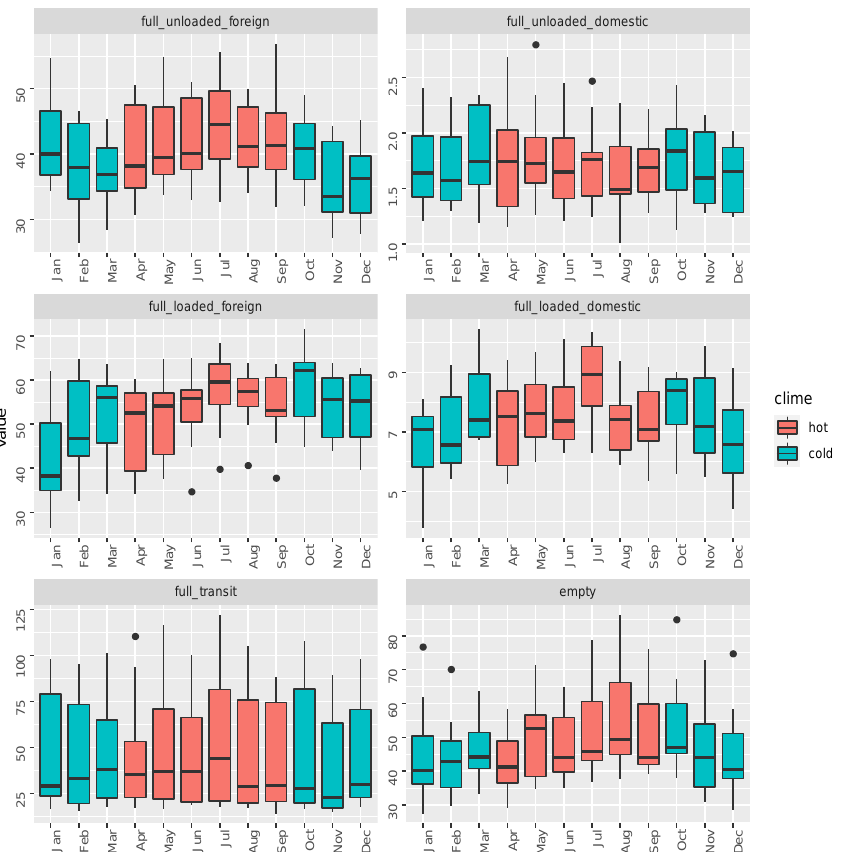
Figure 4. Seasonal box plotsof the container traffic volume